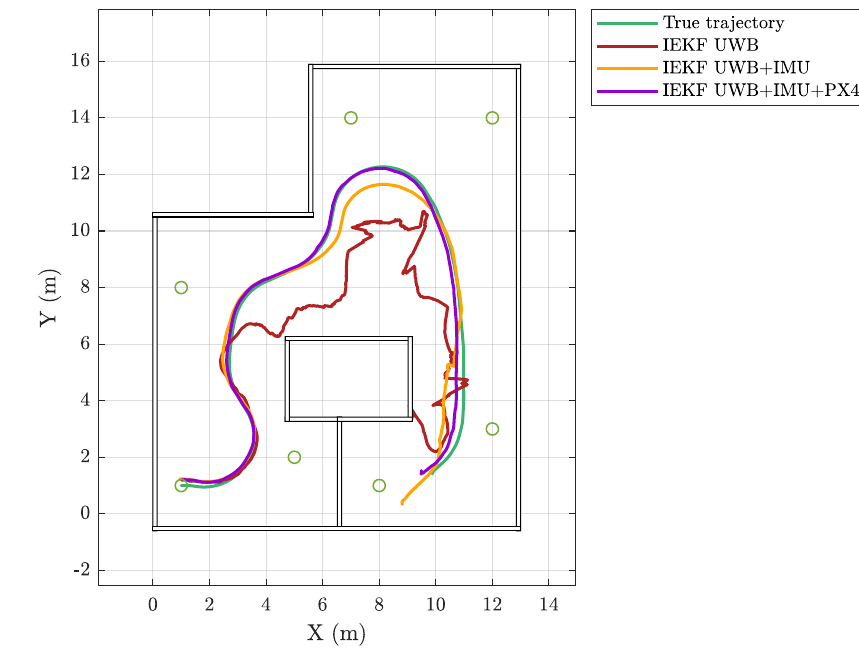
Figure 9. Trajectories using different sensors in scenario